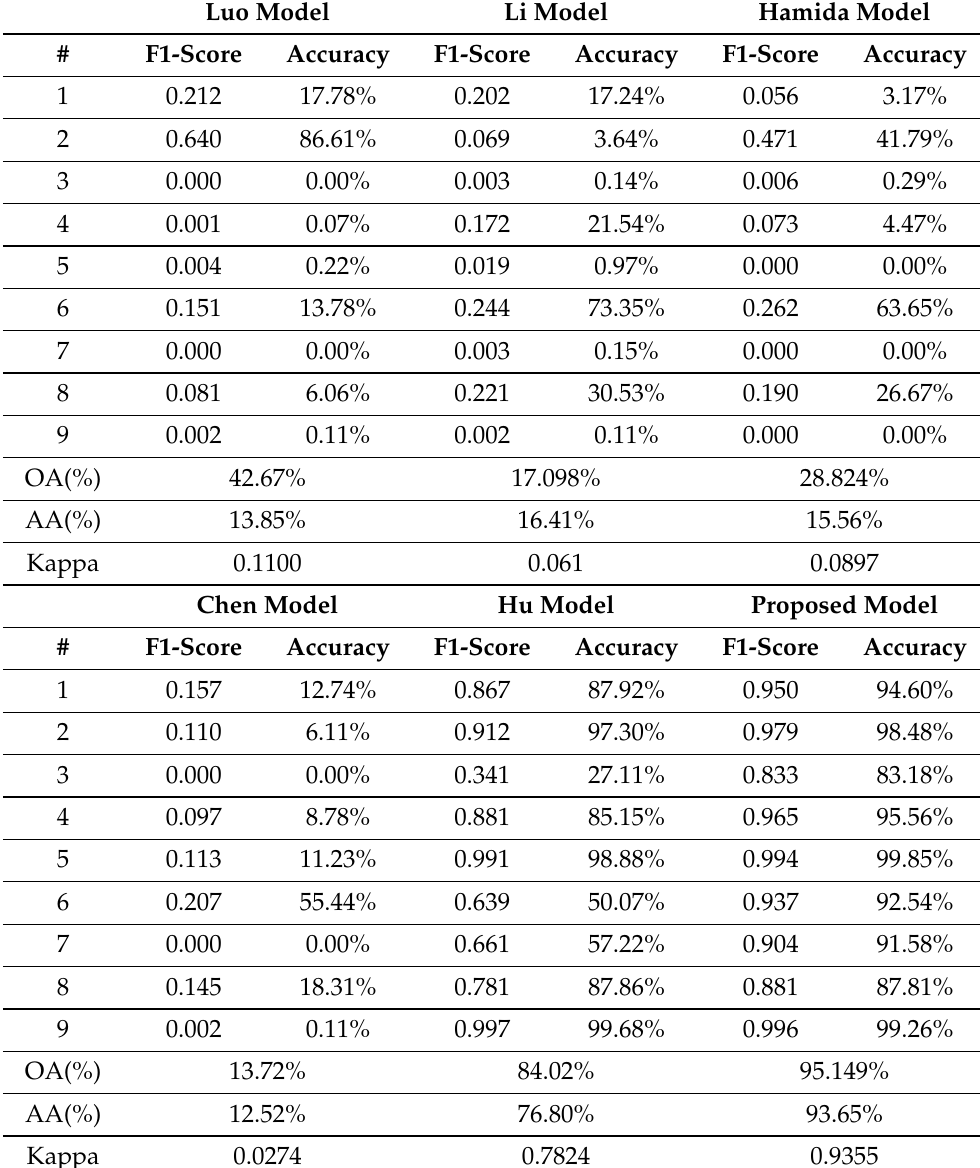
Table 15. Classification results of the Paviua University dataset to which random spatial information is not applied for training and random spatial information to